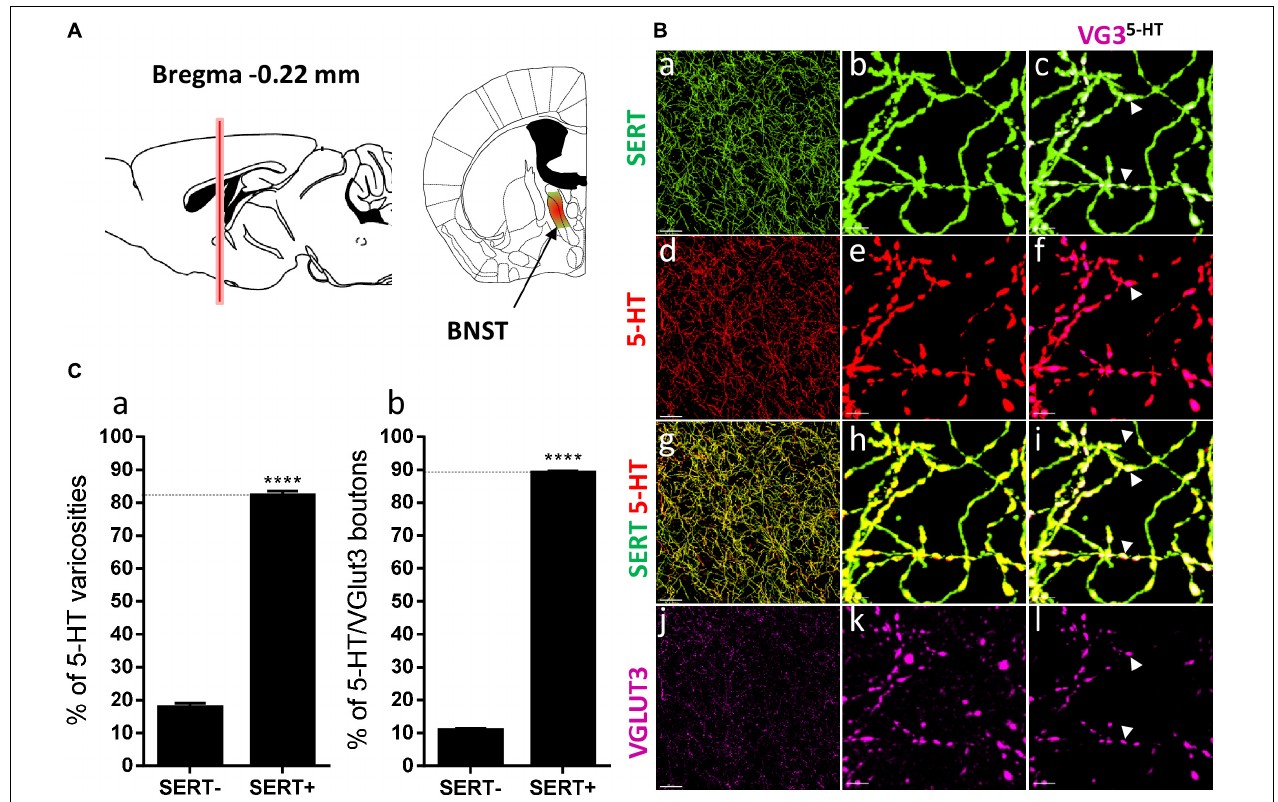
FIGURE 5 | Distribution of VGLUT3 + boutons within 5-HT + and SERT + axons in the bed nucleus of the stria terminalis. (A) Schematic drawing showing the location of the acquired micrographs. The bed nucleus of the stria terminalis (BNST) mosaic images were acquired at bregma –0.22 ± 0.3 mm (red vertical line) in the medial posteromedial BNST (BSTMPM) and postero-intermediate part of the BNST (BSTMPI) (green/red area). (B) Micrograph showing the distribution of the SERT (green, a–c ), 5-HT (red, d–f ), SERT (green) + 5-HT (red) ( g–i ), and VGLUT3 (magenta, j–l ) in the BNST. Left panel (a,d,g,j) shows lower magnification. Scale bar: 50 µ m. Middle (b,e,h,k) and right (c,f,i,l) panels show higher magnification of the white dashed box in the left panel (a,d,g,j) . Scale bar: 2 µ m. The right panel (c,f,i,l) shows the VGLUT3 boutons co-labeled with SERT (c) , 5-HT (f) , and SERT + 5-HT (i) . VGLUT3 puncta located within 5-HT varicosities were isolated using Imaris (l) . Arrowheads show 5-HT varicosities collocated with SERT and VGLUT3 (c,f,i,l) . (C:a) Quantification of the proportion of 5-HT varicosities not co-labeled (SERT - ) and co-labeled (SERT + ) with SERT in the BNST, showing a great majority of 5-HT varicosities co-labeled with SERT. (b) Quantification of the proportion of 5-HT + /VGLUT3 + not co-labeled (SERT - ) and co-labeled (SERT + ) with SERT in the BNST, showing a great majority of 5-HT + /VGLUT3 + varicosities co-labeled with SERT ( t -test, ∗∗∗∗ p <